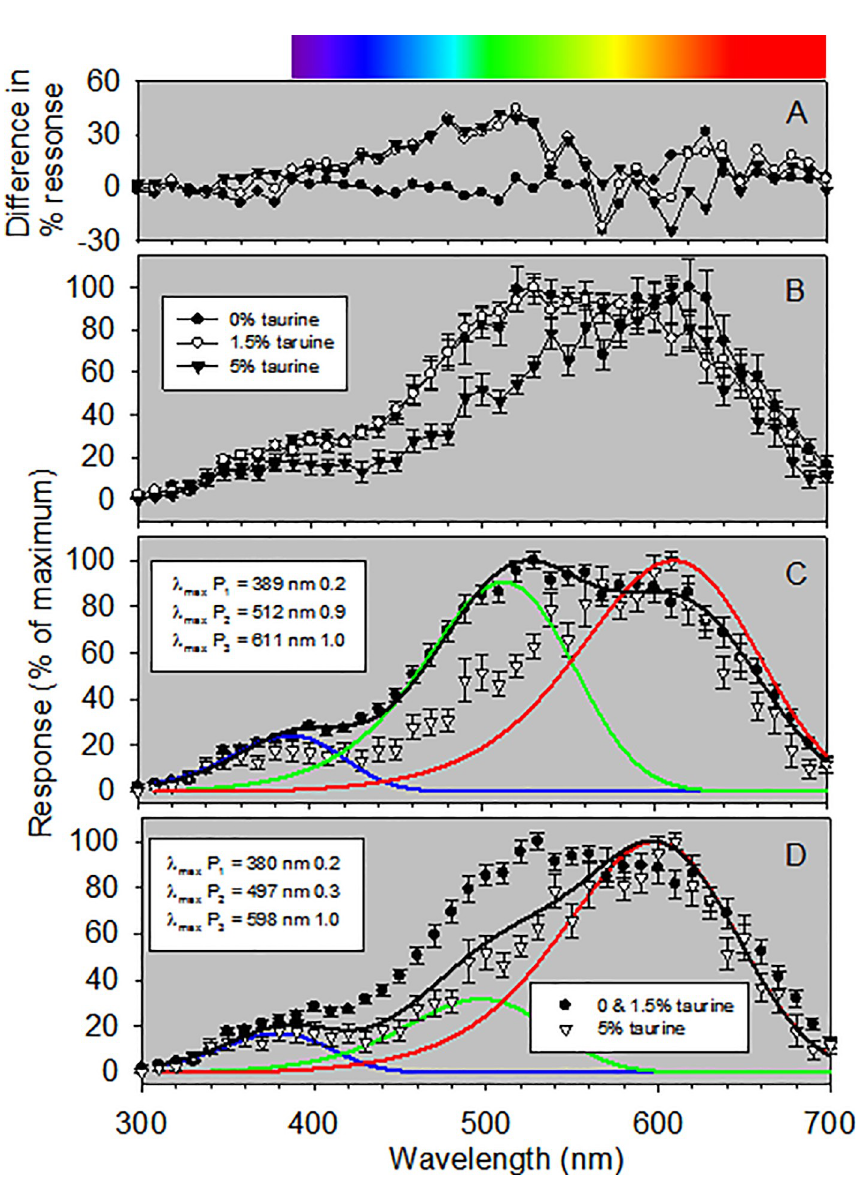
Fig 7. Spectral sensitivity (i.e., responses to monochromatic light) of European sea bass. Data are mean values ( ± SEM). Response values for individuals were normalized to 0–100%, the values averaged, and the mean values rescaled to 0–100%. Panel A are the differences between mean values of responses of fish fed the three different diets. Panel B are the mean responses of fish feed 0%, 1.5%, and 5% taurine diets. In both panels, fish feed 0%, 1.5%, and 5% taurine diets are indicated by filled circles, open circles and filled triangles, respectively. Because the spectral sensitivities of fish fed 0% or 1.5% taurine diets were largely not different, the data from these individuals were combined and the mean relative responses shown in panels B and C. Wavelengths at maximal absorptions ( λ max values) and pigment-specific weight values (to the right of each λ max value) are shown. Black lines are the summed curves of the visual pigment curves multiplied by their respective weighting factors. Color coded lines indicate the absorptive characteristics of individual visual pigments. The color bar at the top of the figure shows the approximate human visual spectrum.